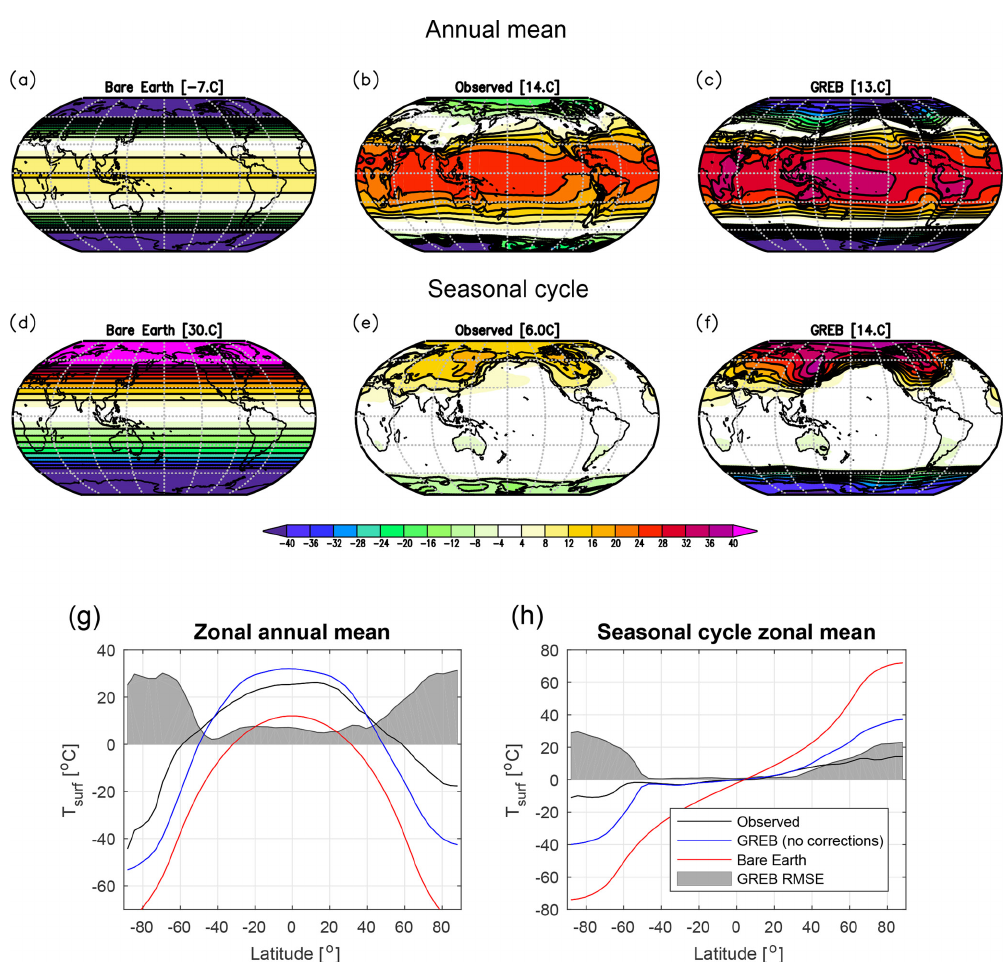
Figure 4. T surf annual mean (a, b, c) and seasonal cycle (half the difference between mean of July to September minus January to March; d, c, f ) for the GREB experiment with all processes turned OFF (bare Earth), only the correction term OFF (GREB), and observed (identical to GREB with all processes ON). The zonal mean of the annual mean (g) and seasonal cycle (h) of the experiments and observations in comparison with the zonal mean RMSE of the GREB model without correction terms relative to